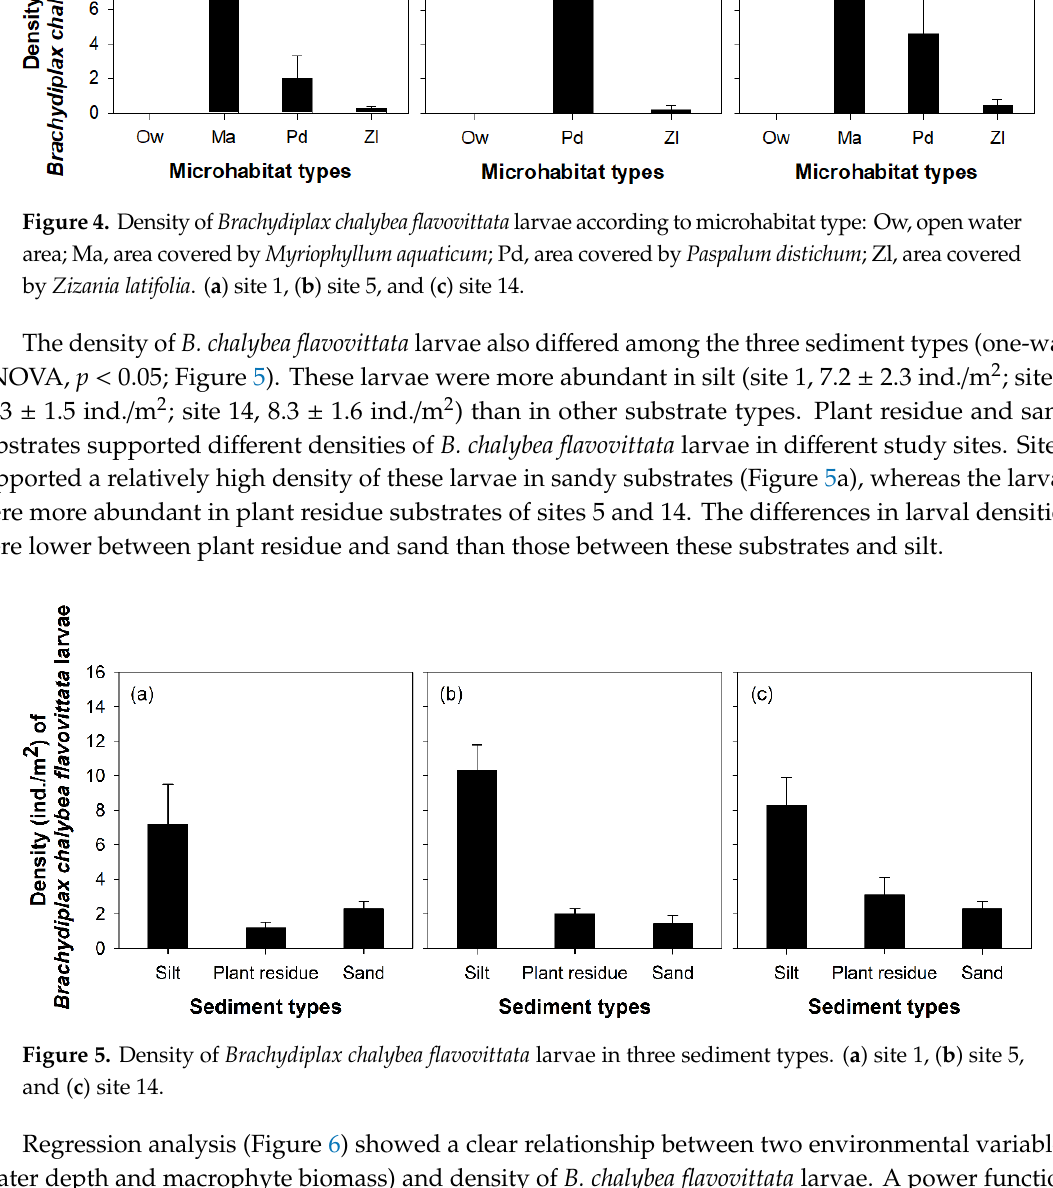
Figure 6. The relationships between the density of Brachydiplax chalybea flavovittata larvae and water depth at sites 1, 5, and 14 (a, b, and c), and with macrophyte biomass at sites 1, 5, and 14 (d, e, and f). 3.3. Stable Nitrogen Isotope Analysis of Odonata Larvae The δ 15 N value differed significantly among the five sampled Odonata larvae species (one-way ANOVA, p < 0.05; Figure 7b and c). The δ 15 N values of larvae collected at site 1 showed no statistical differences, and they displayed a range similar range to that of the other sites (Figure 7a). The five species were clearly divided into two subgroups (a group with four dominant species, and b group